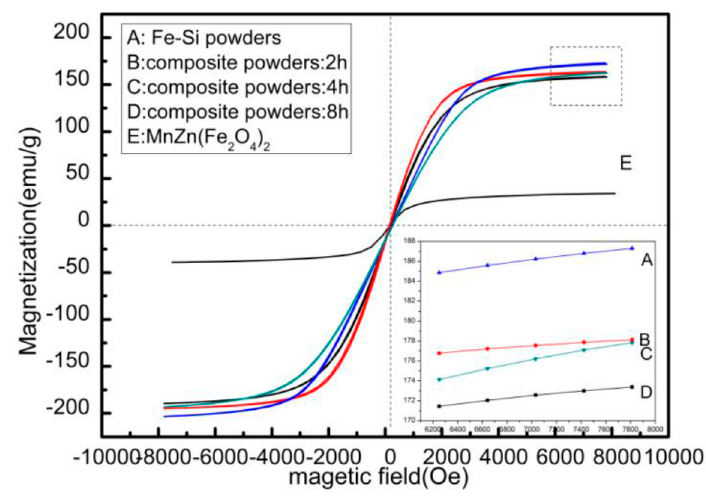
Figure 7. The hysteresis loops of raw Fe-Si powders, MnZn(Fe 2 O 4 ) 2 powders and composite powders with different milling time. The inset in figure is the magnified image of the selected region.